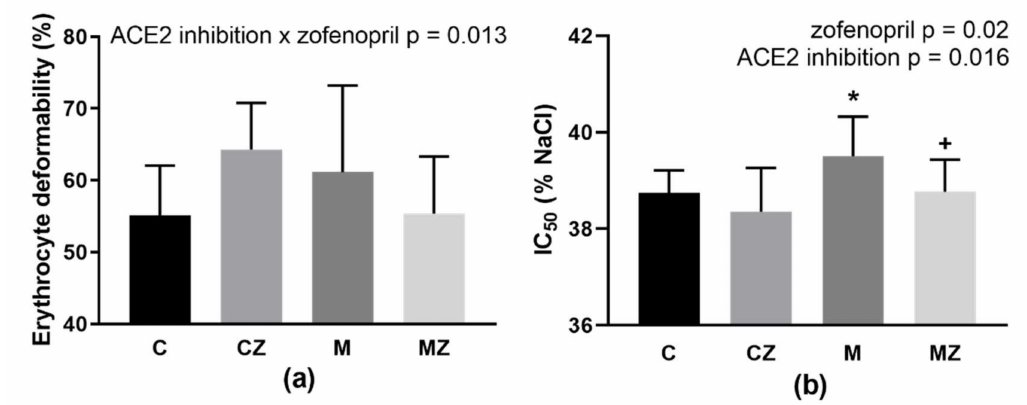
Figure 4. Erythrocyte deformability ( a ) and osmotic resistance (IC 50 ) ( b ). Abbreviations: C—control group, CZ—zofenopril- treated group, M—MLN-treated (MLN-4760, ACE2 inhibitor) group, MZ—zofenopril and MLN-treated group. * p < 0.05 versus control group, + p < 0.05 versus M group. Data are presented as mean ± standard